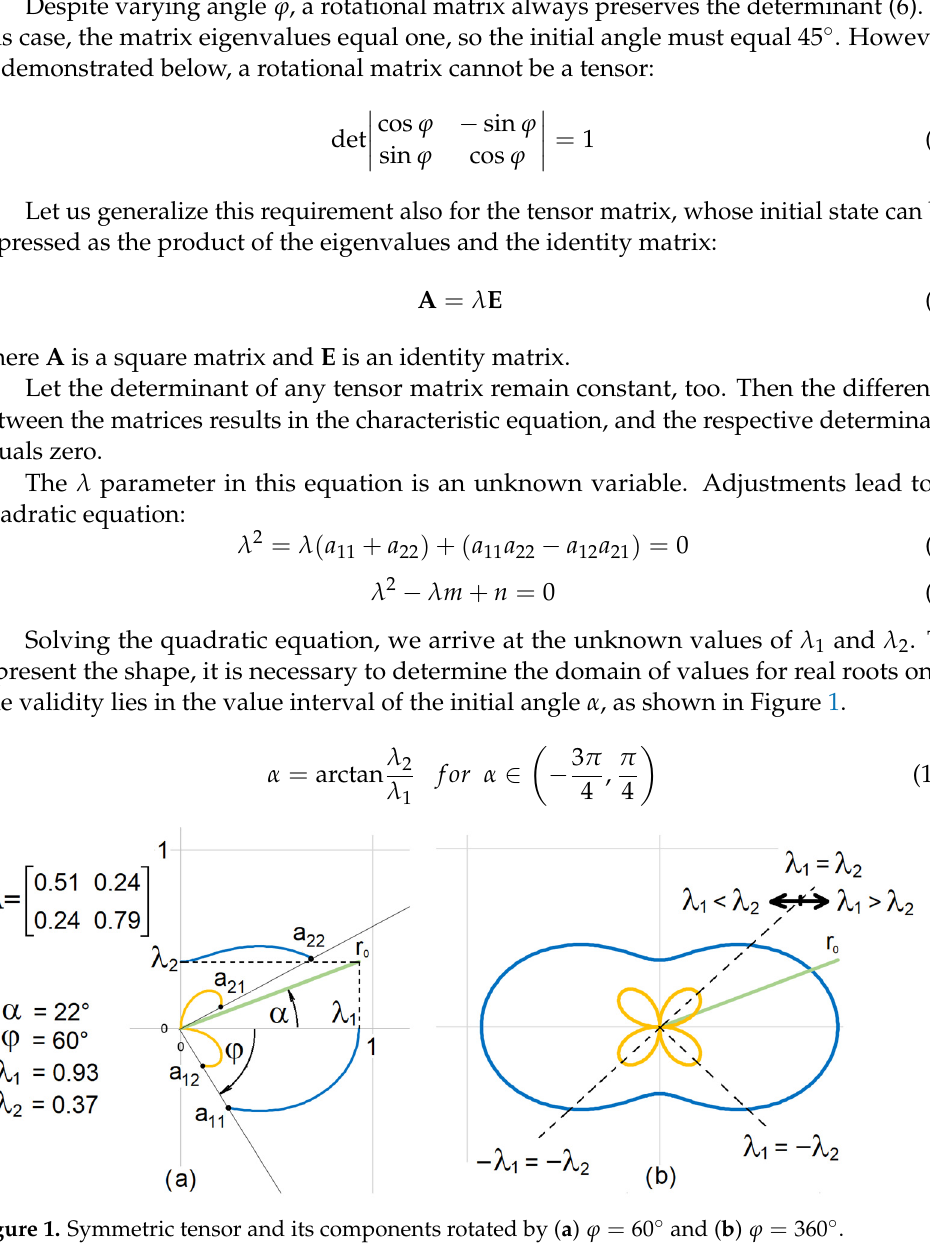
Figure 2. Symmetric tensor glyphs: 𝛼 = −150°, −135°, −100°,and − 80° .